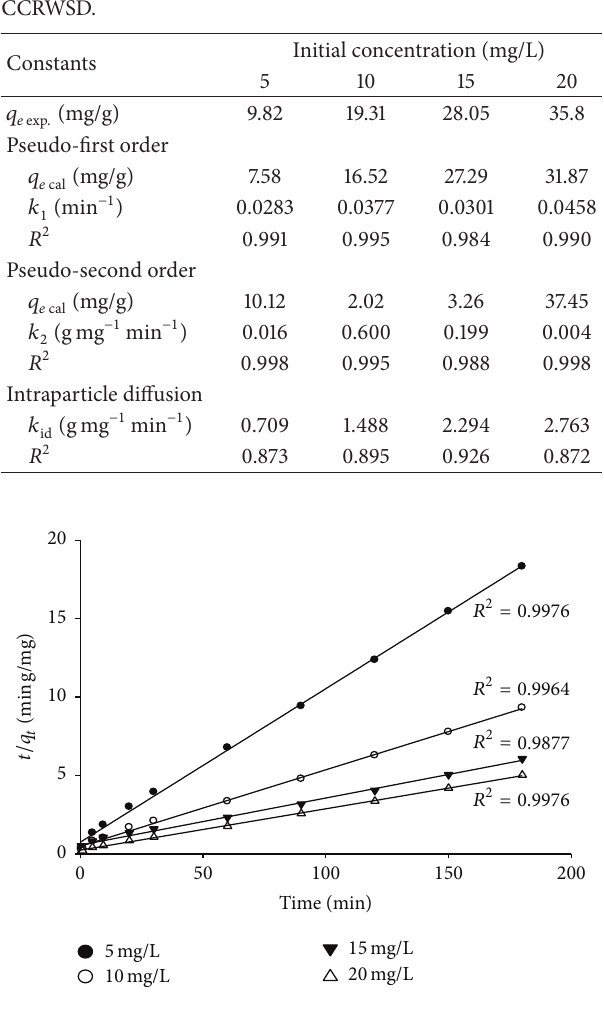
Figure 13: Pseudo-second-order model (pH= 5.6, dose = 0.5 g/L, contact time = 180min, and temperature = 30 ∘ C).